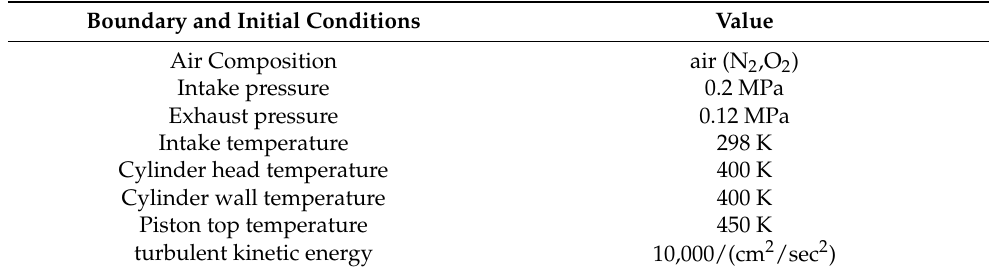
Table 3. Calculation boundary and initial conditions.